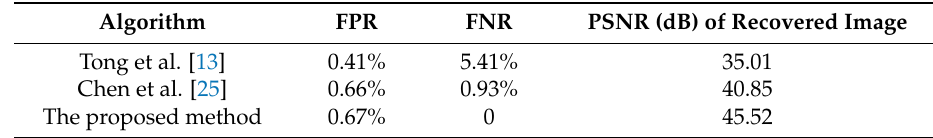
Figure 6. Tamper detection and recovery performance for text addition attack: ( a ) Original Lena image; ( b ) watermarked Lena image; ( c ) attacked image; ( d ) tamper detection result using the method in [13]; ( e ) tamper detection result using the method in [25]; ( f ) tamper detection result of the proposed method; ( g ) image recovery result using the method in [13]; ( h ) image recovery result using the method in [25]; ( i ) image recovery result of the proposed method. Table 3. Performance comparisons for text addition attack using Lena